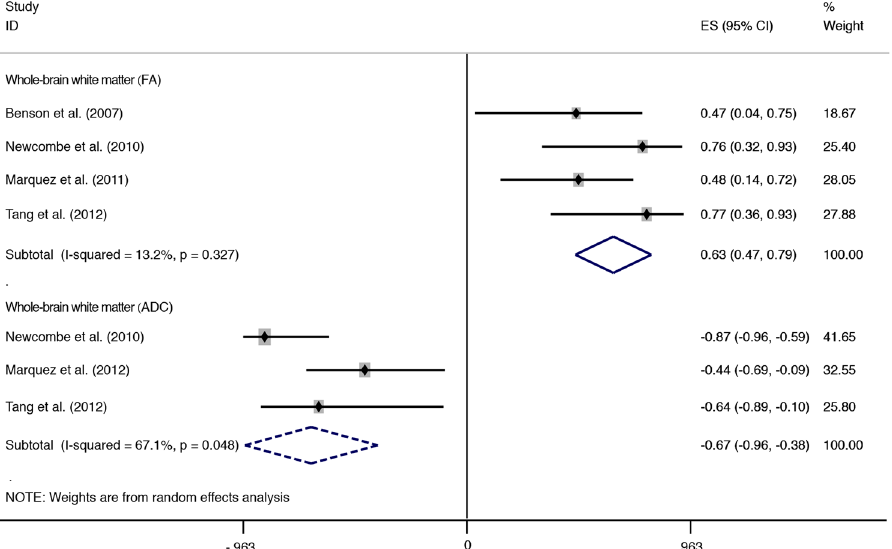
Figure 4. Forest plot showing correlations between consciousness and DTI indices of whole-brain white matter. Solid-line diamonds represent overall r value of FA-consciousness correlations, and dotted diamonds are for ADC-consciousness correlations. FA, fractional anisotropy; ADC, apparent diffusion coefficient; CI, confidence interval.